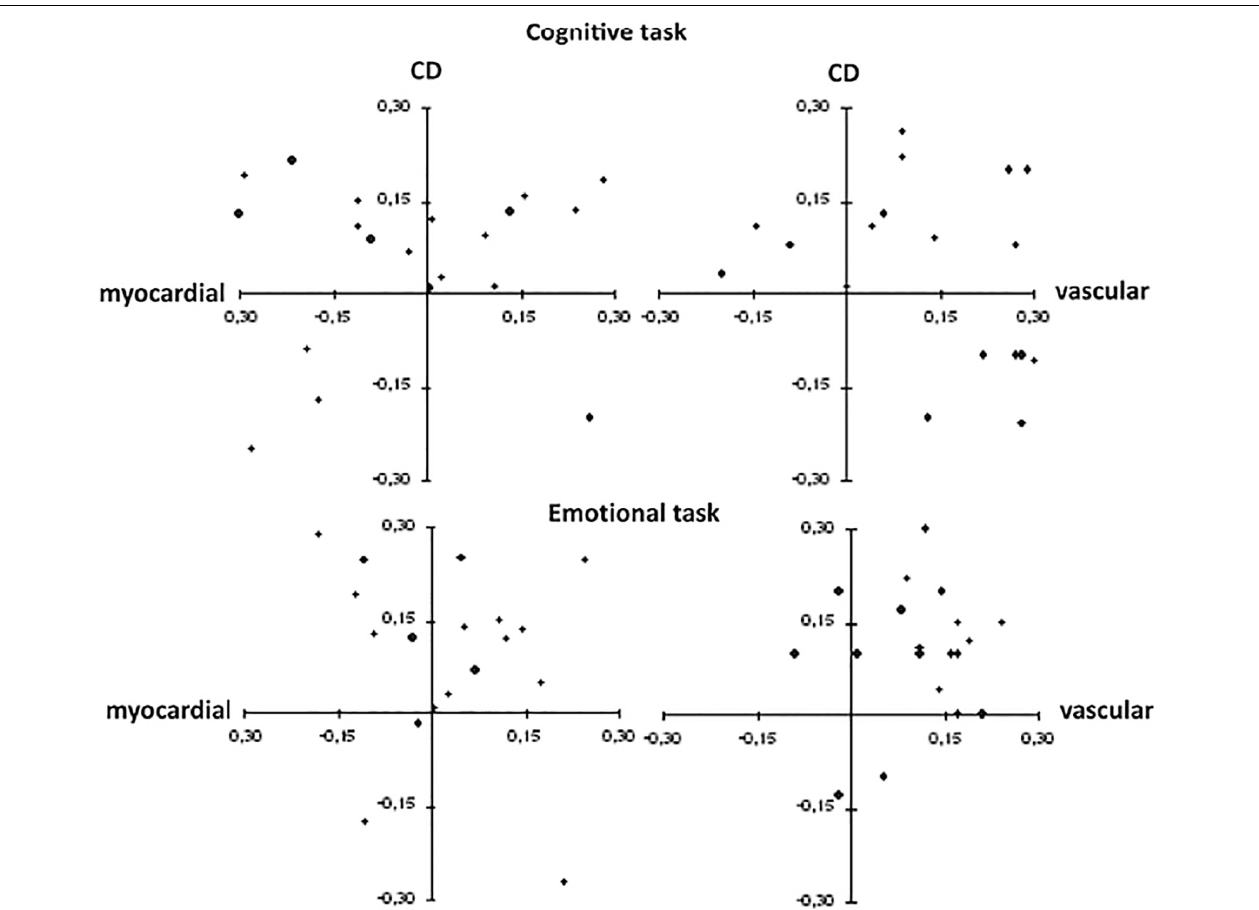
FIGURE 1 | Scatterplots for hemodynamic profile and compensation deficit during each task in heterosexual (right panel) and lesbian, gay and bisexual (left panel) participants. Each point represents each participant’s hemodynamic profile (HP) and compensation deficit (CD). A “more vascular” profile is associated with more positive values along the x -axis and a “more myocardial” profile is associated with more negative values along the x -axis. A “higher deficit” in compensating is associated with more positive values on the y -axis and a “lower deficit” in compensating is associated with more negative values on the y